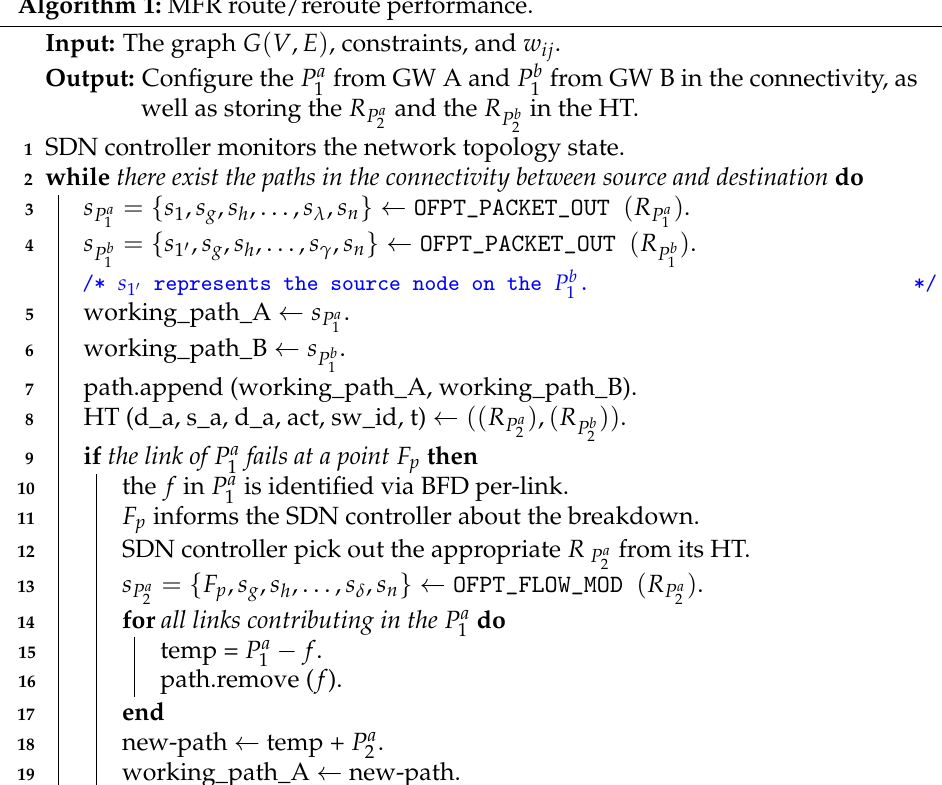
Algorithm 1: MFR route/reroute